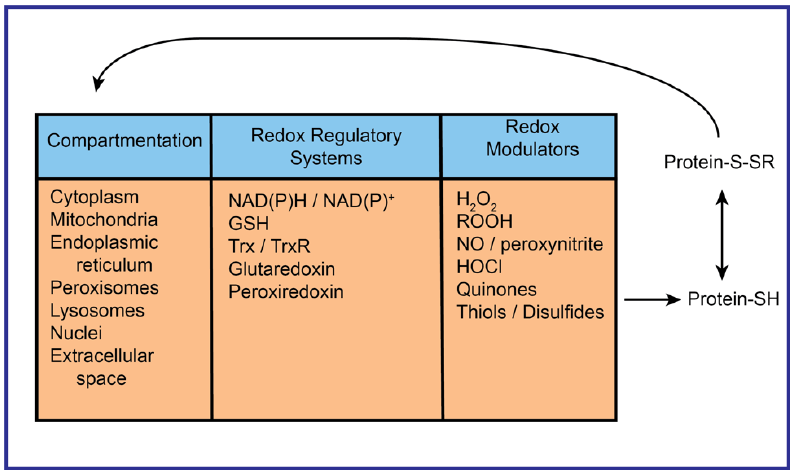
Figure 9. A systems biology approach to redox regulation. The three primary components of the system are subcellular compartments and the extracellular space, several redox regulatory systems, and redox modulators or signaling molecules. Within specific compartments, changes in activities of redox regulatory systems lead to changes in the concentrations of redox modulators. These, in turn, alter the redox state of protein-cysteinyl residues, which, in turn, impact function in the different cellular or subcellular compartments. Abbreviations: GSH: reduced glutathione; NO: nitric oxide; ROOH: organic peroxide; Trx: thioredoxin; TrxR: thioredoxin reductase.